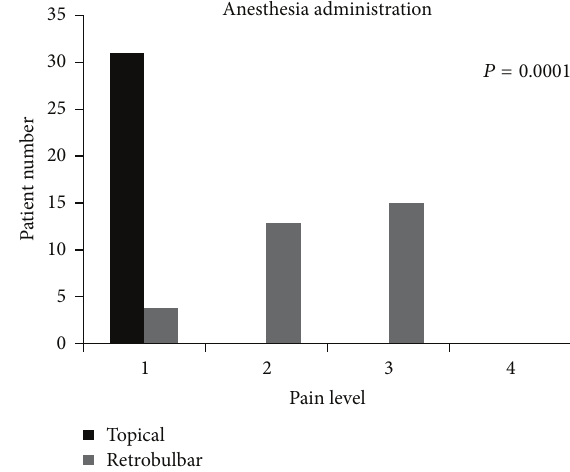
Figure 1: The pain scores recorded for delivery of anesthesia.